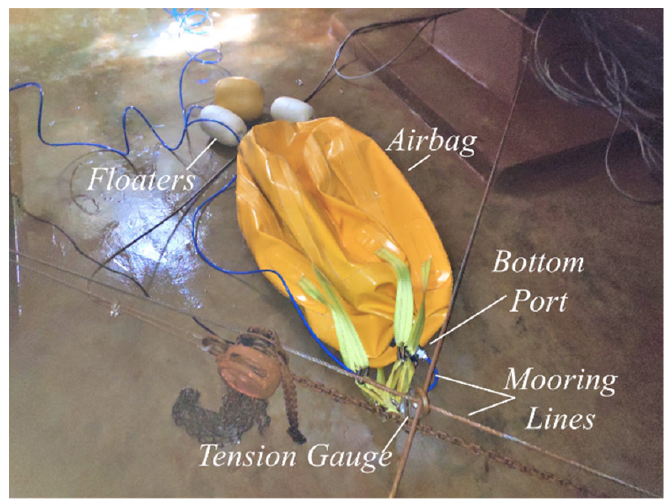
Figure 3. Installation of the empty airbag model, tension gauge, and mooring lines.